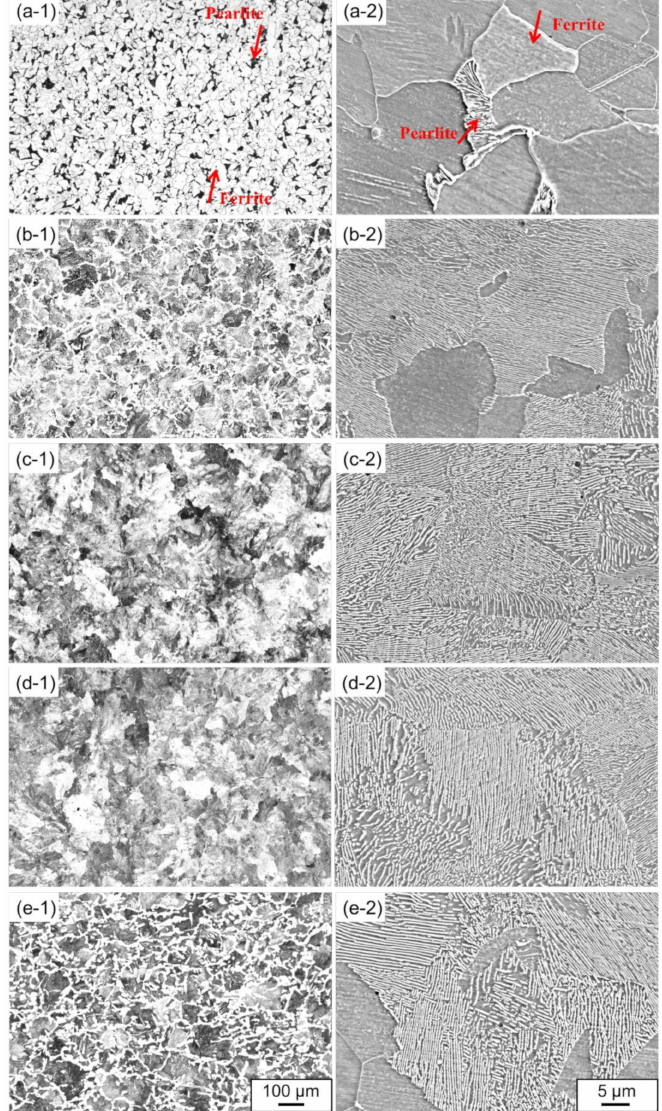
Figure 1. OM and SEM images of microstructures for the rail steels: ( a ) 1904, ( b ) 1911, ( c ) 1917, ( d ) 1919, ( e ) 1921, respectively as shown in (-1) and